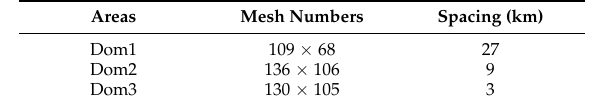
Table 1. Design of the model simulation areas.